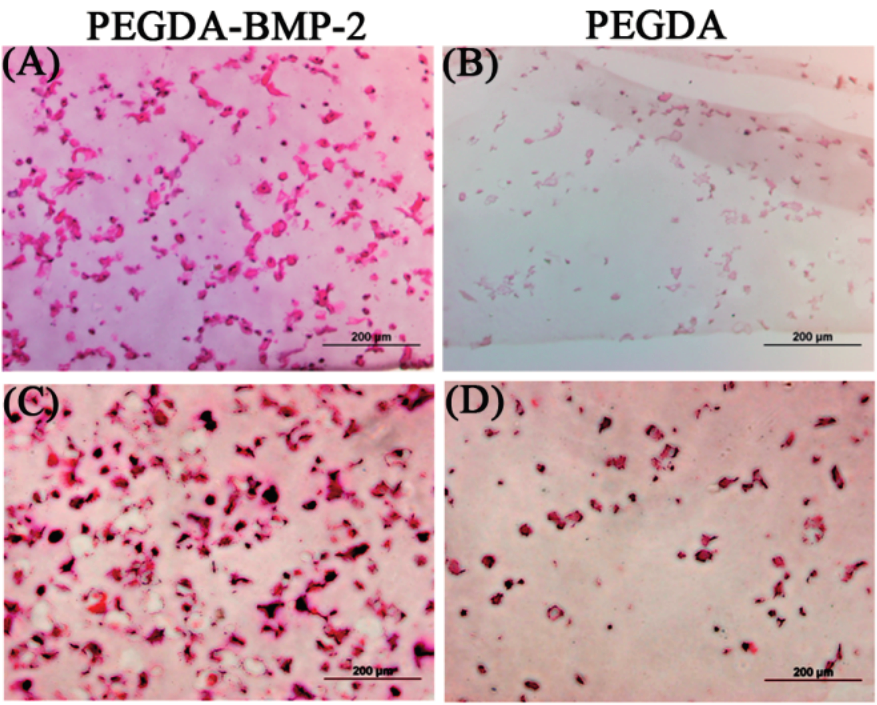
Figure 5. Representative H&E stain ( A , B ) and Alizarin Red S stain ( C , D ) of PEGDA-BMP-2 ( A , C ) and PEGDA ( B , D ) photo-responsive hydrogels containing LFs after 28 days of culture. Scale bar = 200 μ